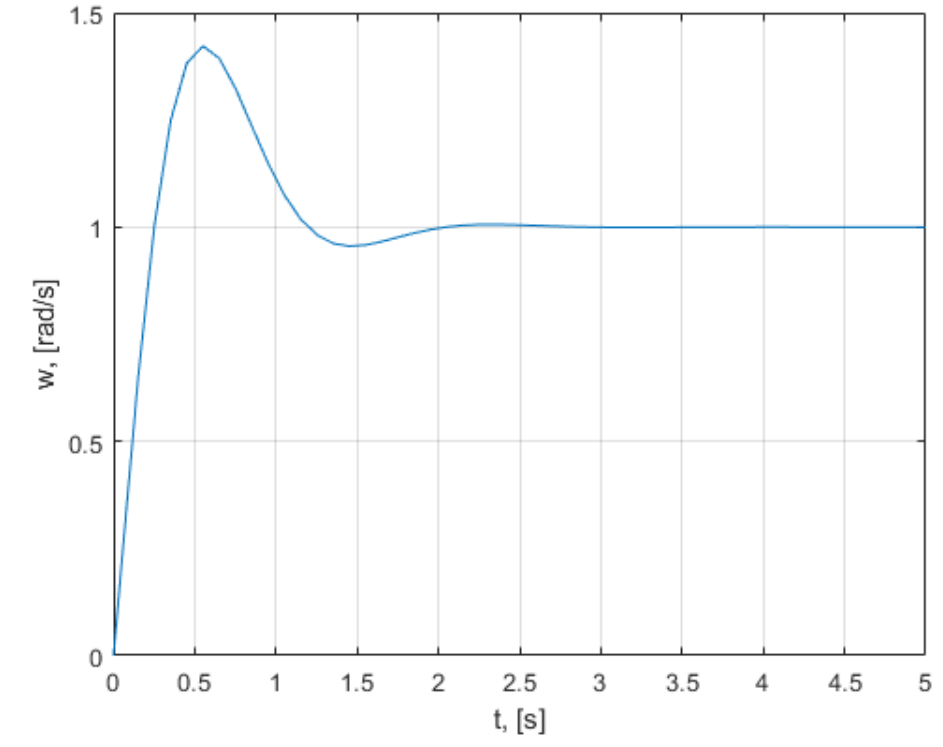
Figure A1. The step response of speed control system.